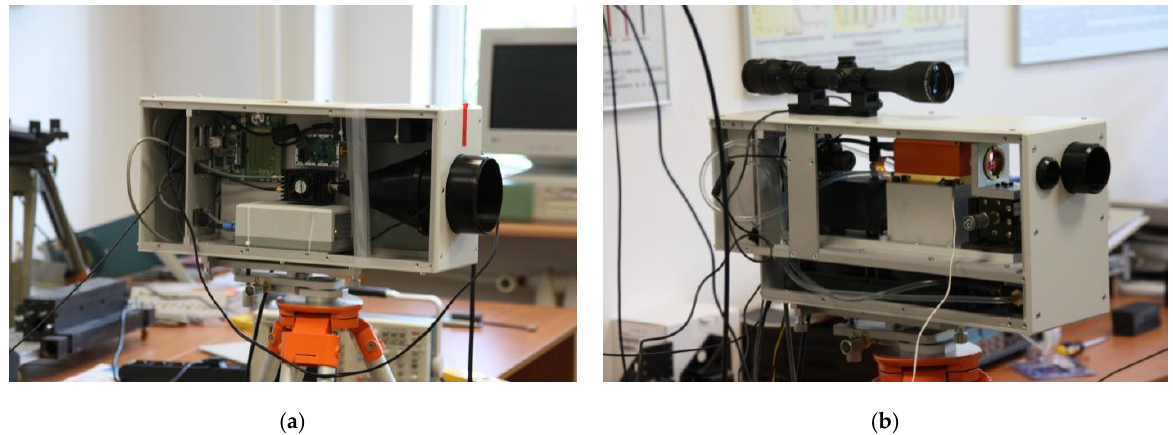
Figure 4. Photo of the receiving ( a ) and transmitting ( b ) modules of the FSO link.